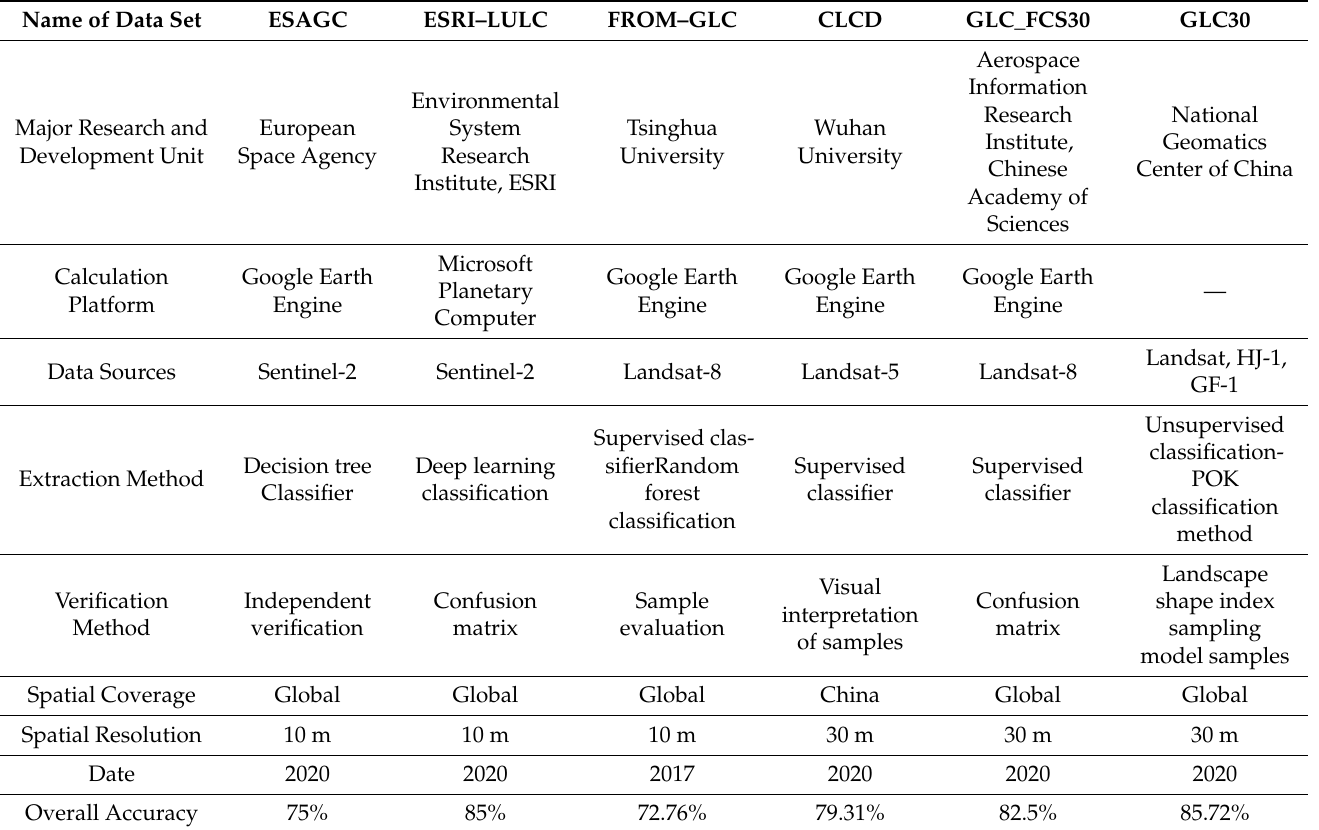
Table 1. Details of the six land cover data sets used in this